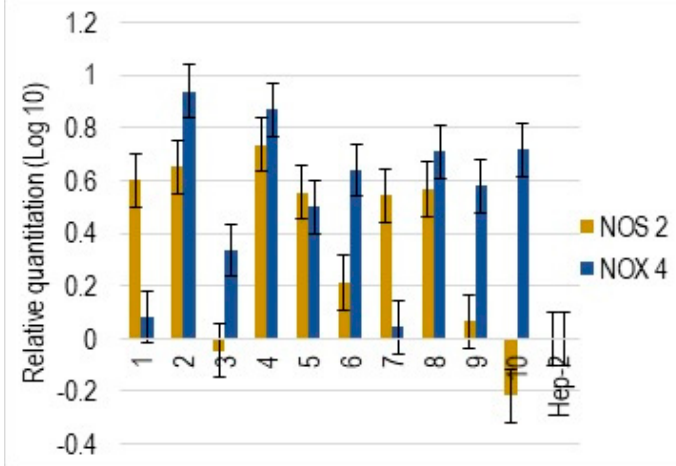
Figure 6. The effects of azulene ‐ containing chalcones on NOS2 and NOX4 expression.